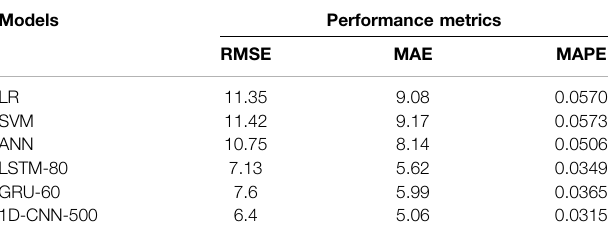
TABLE 4 | Comparison of AI models for NOx emissions test data.